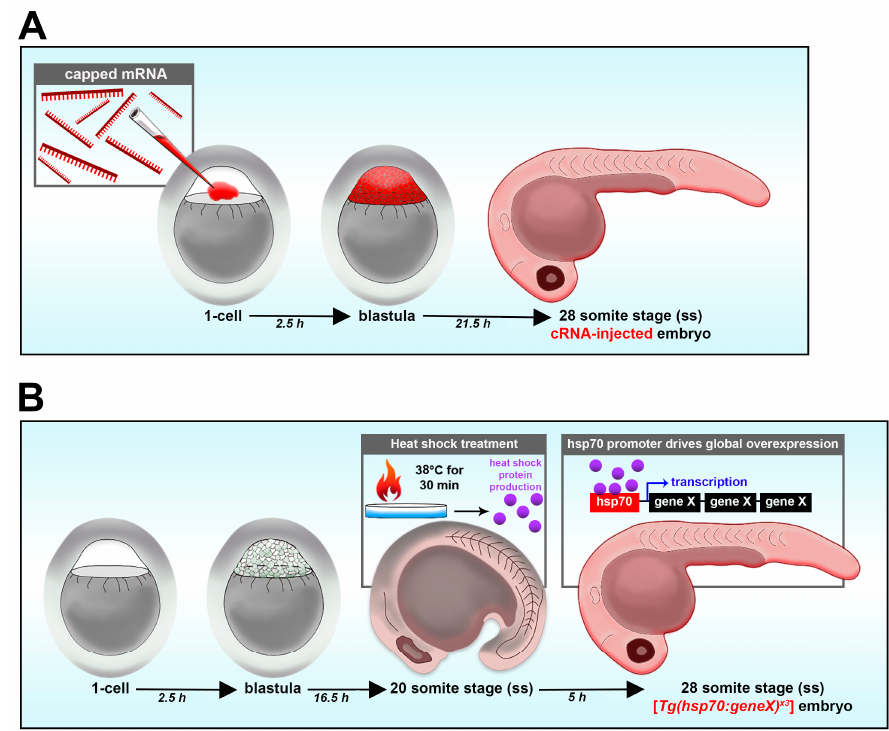
Figure 3. Reverse genetic gain-of-function strategies in the zebrafish embryo. ( A ) Overexpression through mRNA delivery. ( B ) Transgenic mediated overexpression.